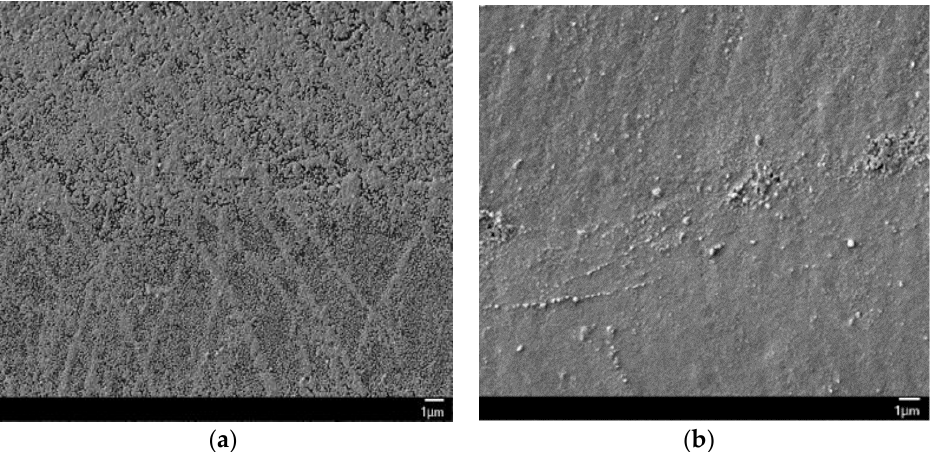
Figure 4. SEM images of the silver film fabricated from the reaction solution with ( a ) ethylene glycol, ( b ) propylene